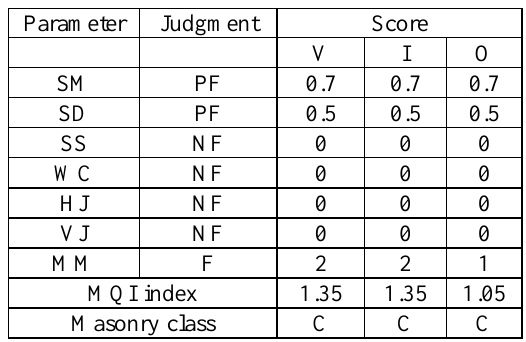
Table 1. Analysis of ‘Desert Rose’ stone